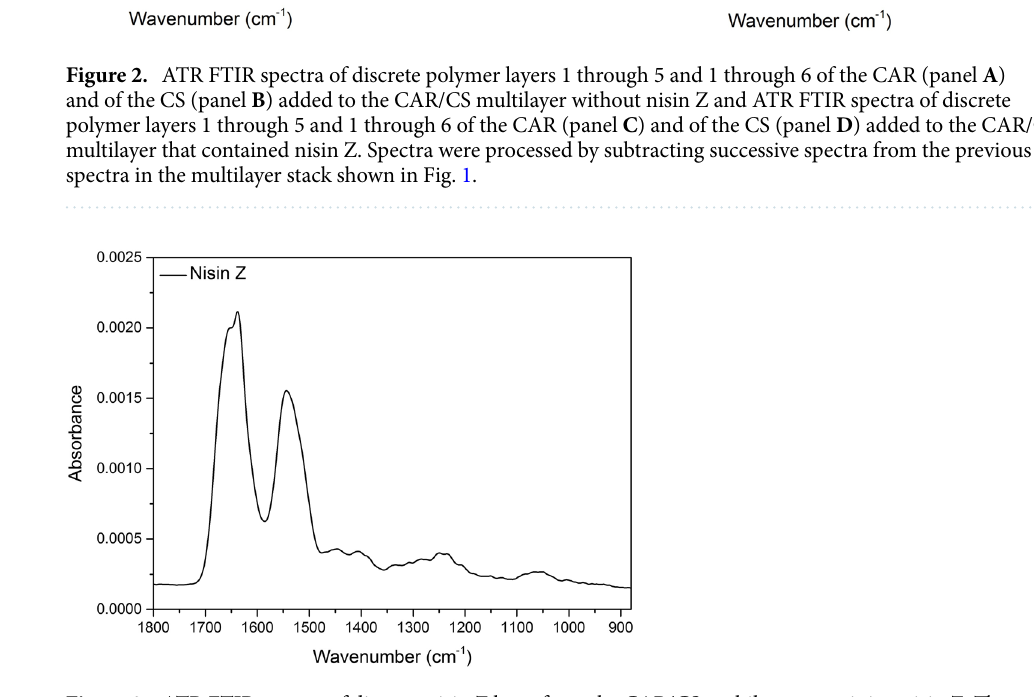
Figure 3. ATR FTIR spectra of discrete nisin Z layer from the CAR/CS multilayer containing nisin Z. The spectrum was processed by subtracting the previous spectrum (CAR4) from the spectrum collected after nisin incorporation in the multilayer stack shown in Fig.